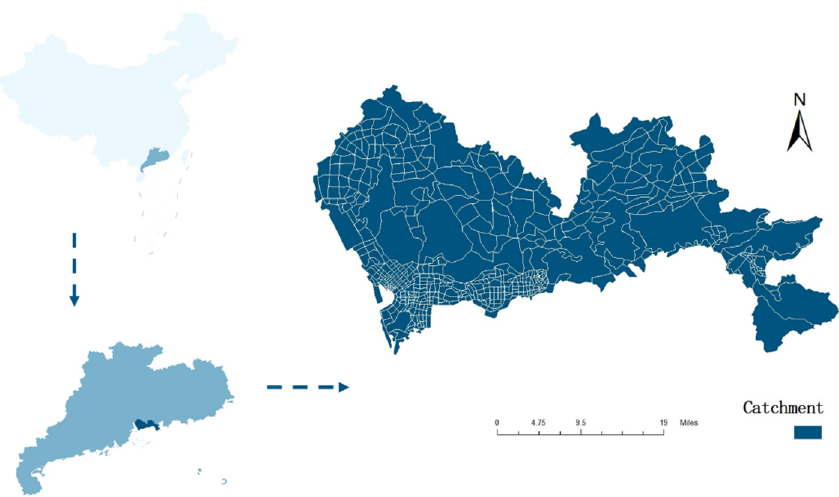
Figure 1. The Shenzhen City regional catchment division.